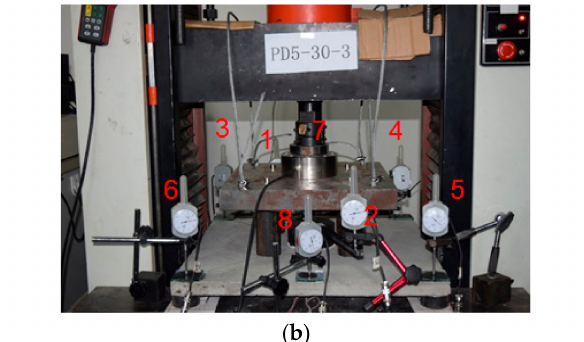
Figure 5. Loading device and arrangement of measuring points. ( a ) Loading sketch map; ( b ) Loading field.